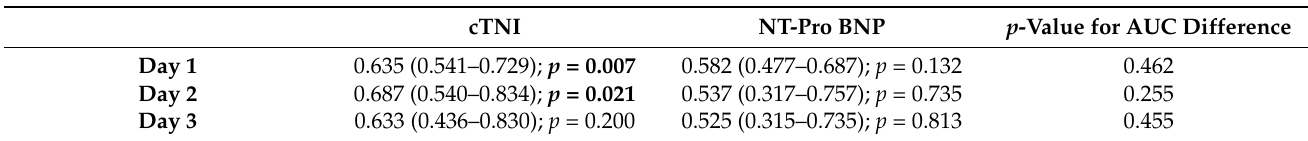
Table 5. C-statistic for biomarkers at days 1, 2 and 3 to discriminate between non-survivors and